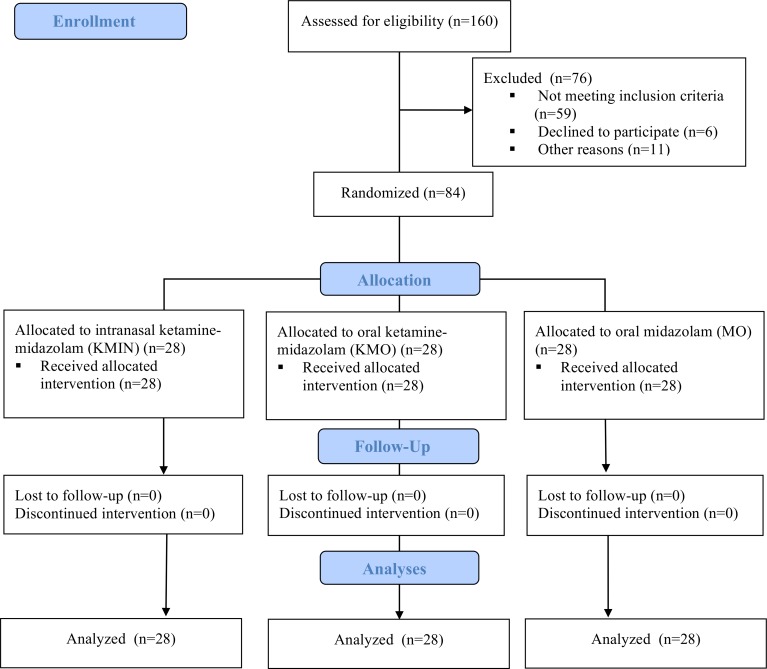
CONSORT flowchart of clinical trial progress stages.